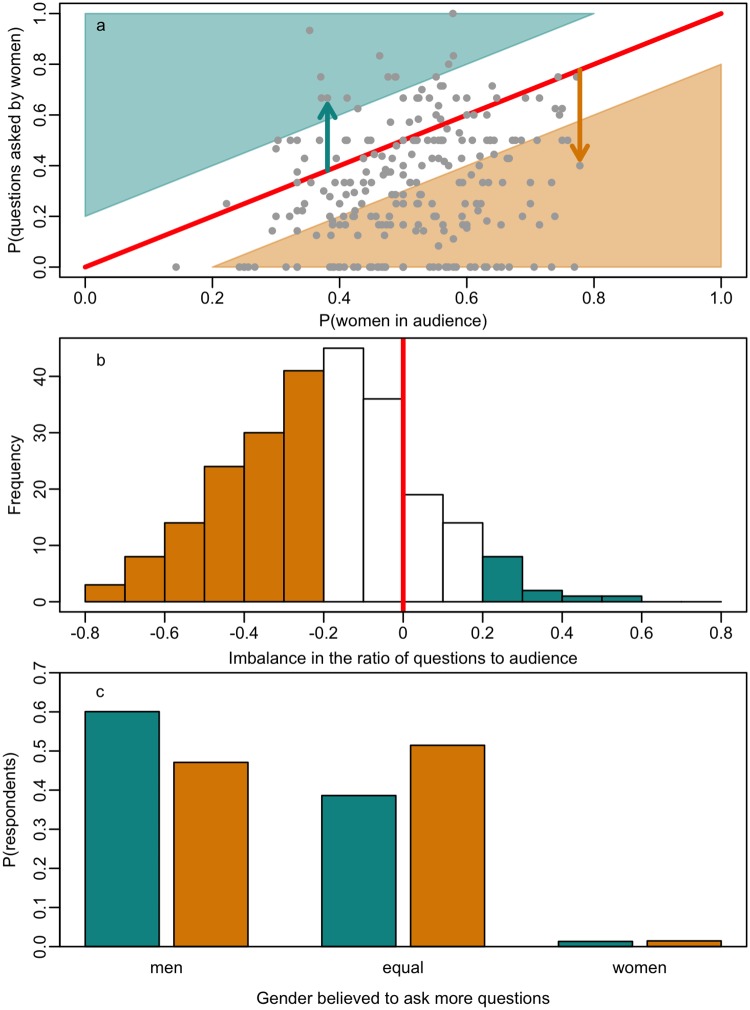
The gender “disparity” in question-asking.A (a) scatter plot of the proportion of women in the audience plotted against the proportion of questions asked by women after a seminar, (b) a histogram of the size of the disparity at each seminar, and (c) a barchart of the beliefs of each gender about whether there is a disparity. Panel (a) shows a visual representation of the disparity in the proportion of questions asked by women (i.e., the difference in the proportion of women in the audience and the proportion of questions asked by women). Points falling in the lower orange half of the plot indicate a disparity towards men, whilst points falling in the upper green half indicate a disparity towards women audience members. Indicated are two seminars that fall in different categories. The green arrow indicates a seminar with a bias towards questions from women, in which the proportion of women in the audience was 0.38, but the proportion of questions asked by women was 0.67. Conversely, the orange arrow indicates a seminar with a bias towards questions from men, in which the proportion of women in the audience was 0.78 but the proportion of questions asked by women was 0.40. Panel (b) shows the frequency at which the disparities were observed, with orange bins indicating seminars with questions disproportionately asked by male audience members and green bins indicating seminars with questions disproportionately asked by female audience members. In both panels, the red line indicates no disparity (i.e., the proportion of the women in the audience matched the proportion of questions asked by women). Panel (c) shows the proportions of female (green) and male (orange) respondents who indicated that they believed that men or women asked more questions in seminars, or that questions were asked equally by men and women.